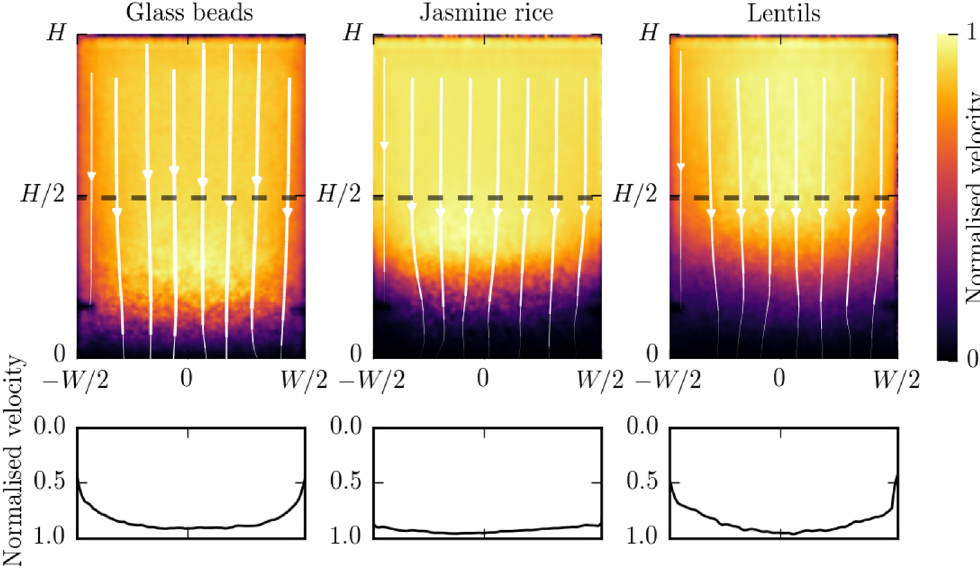
Figure 4. Velocity field during developed flow measured from detector B for the largest outlet, D = 15 mm. Top: Normalised velocity magnitude and streamlines (in white). Bottom : Normalised vertical velocity along the dashed lines. Left to Right: Glass beads, jasmine rice and red lentils. Normalisation velocities are 24.6, 26.4 and 27.1 mm/s, respectively.